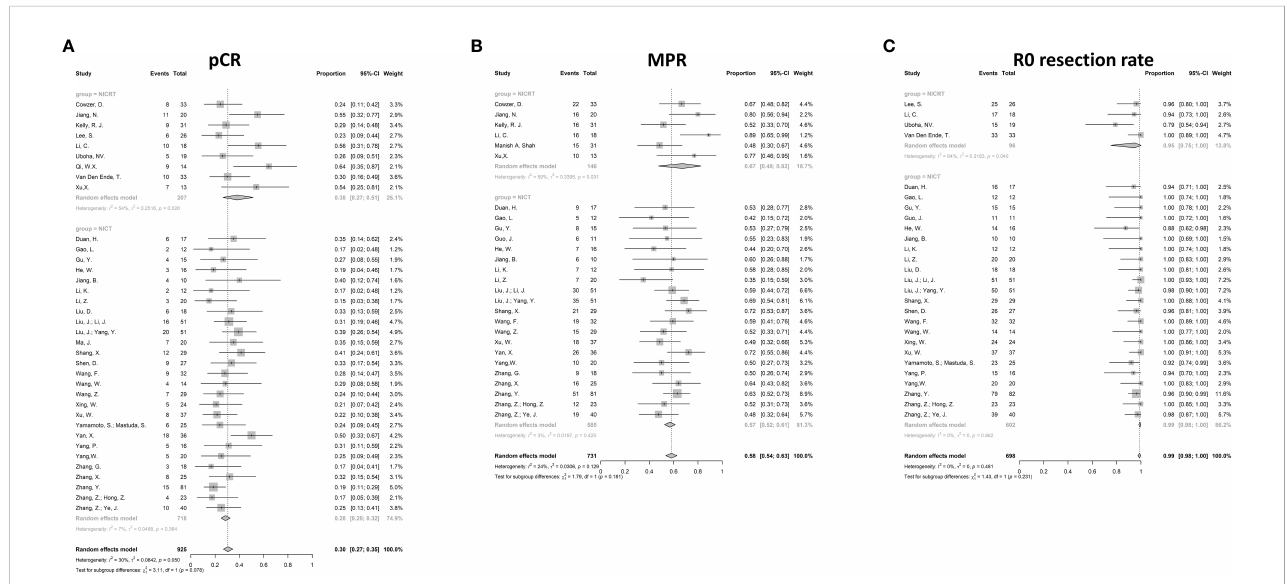
FIGURE 3 Forest plots for ef fi cacy. (A) Pathological complete response (pCR), (B) Major pathological response (MPR), and (C) R0 resection rate. NICRT, neoadjuvant immune-chemoradiotherapy; NICT, neoadjuvant